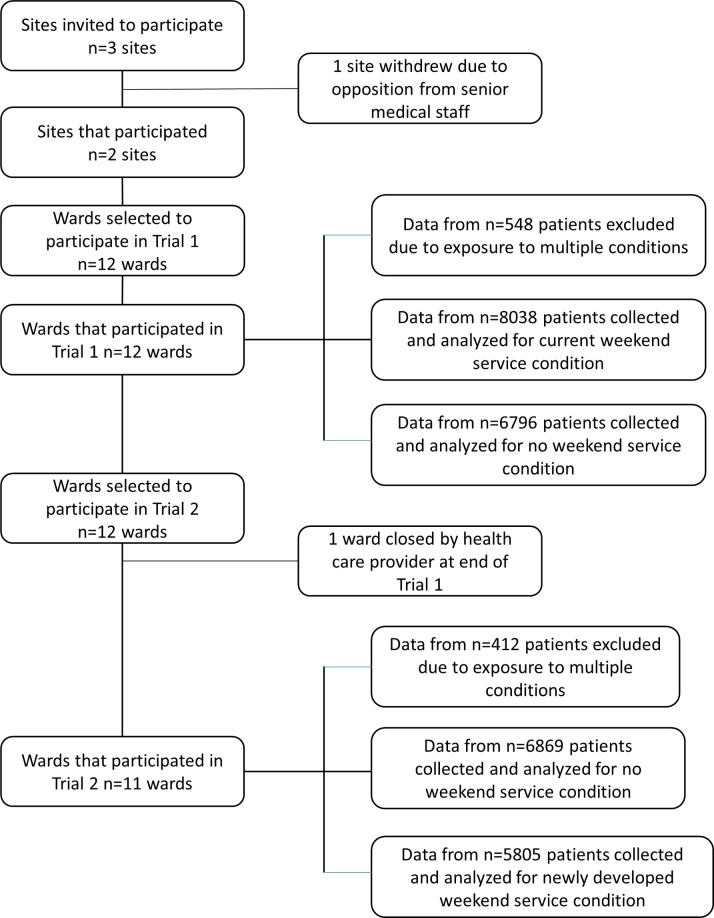
CONSORT flow chart of site, ward, and patient involvement in data collection and analysis.